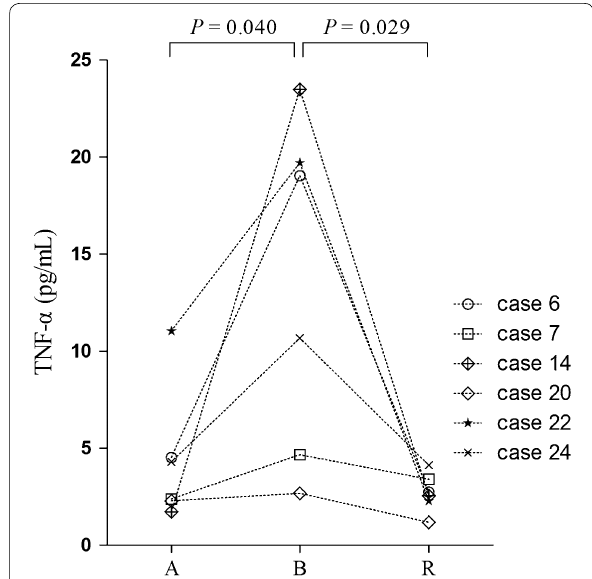
Fig. 5 TNF‑α levels in serum and blister fluid of patients with SJS/ TEN. Each symbol represents the cytokine concentration from a patient. Statistical significance was determined by Student’s t test. A acute stage, B blister, R resolution